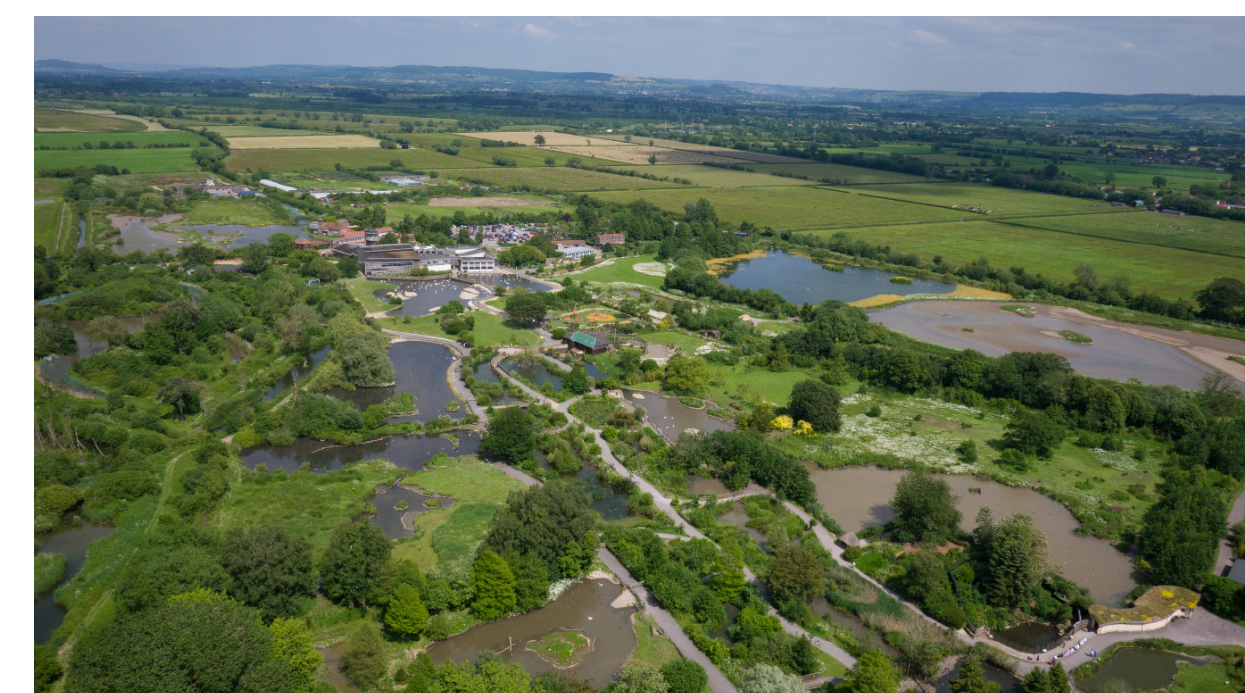
Figure 1. Slimbridge Wetland Centre, Gloucestershire, UK; an example of a wetland centre used in this study. Wetland centres function as both visitor attractions and protected natural areas. The central grounds area (47 ha at Slimbridge) features a visitor centre—including a cafe, an education centre and offices. The adjacent grounds feature a captive wildfowl collection, bird hides and children play areas. The protected natural areas (270 ha at Slimbridge; Site of Special Scientific Interest (SSSI), a Special Protection Area (SPA) and a Ramsar Site) surround the central visitor centre area and grounds. Image: WWT.